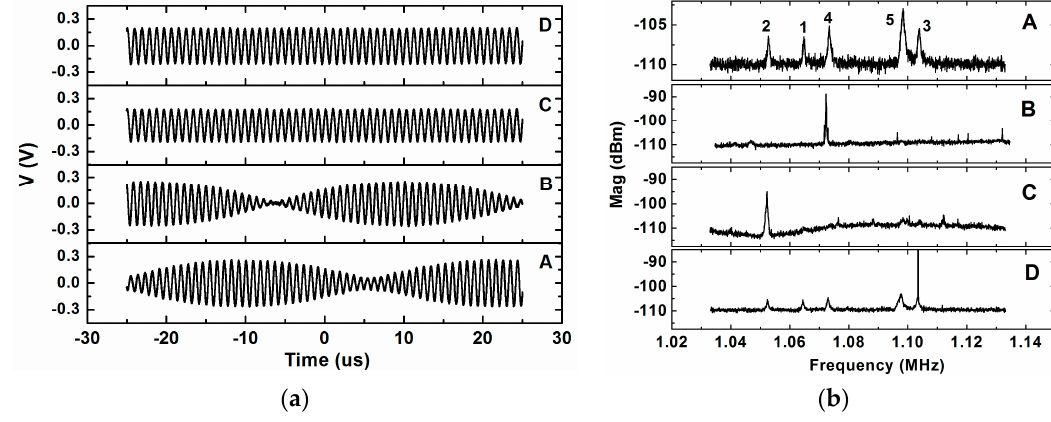
Figure 5. ( a ) Time response signal of the closed-loop self-oscillation of the system with stimulation on cantilever number 4 with DC voltage of 18 V and using different amplitudes peak-to-peak: A , 350 mV; B , 450 mV; C , 500 mV; D , 600 mV; ( b ) Thermomechanical noise plus excitation with DC voltage of 24 V in open-loop configuration: A , without excitation; B , excitation on cantilever number 4 at its modal frequency with 650 mV of amplitude, where we can see that peak number 4 stands above the others; C , excitation on cantilever number 2 at its modal frequency with 650 mV of amplitude, where we can see that peak number 2 stands above the others; D , excitation on cantilever number 2 at the modal frequency of cantilever number 3, where we can see that the five peaks remain and a large and sharp peak appears as number 3.